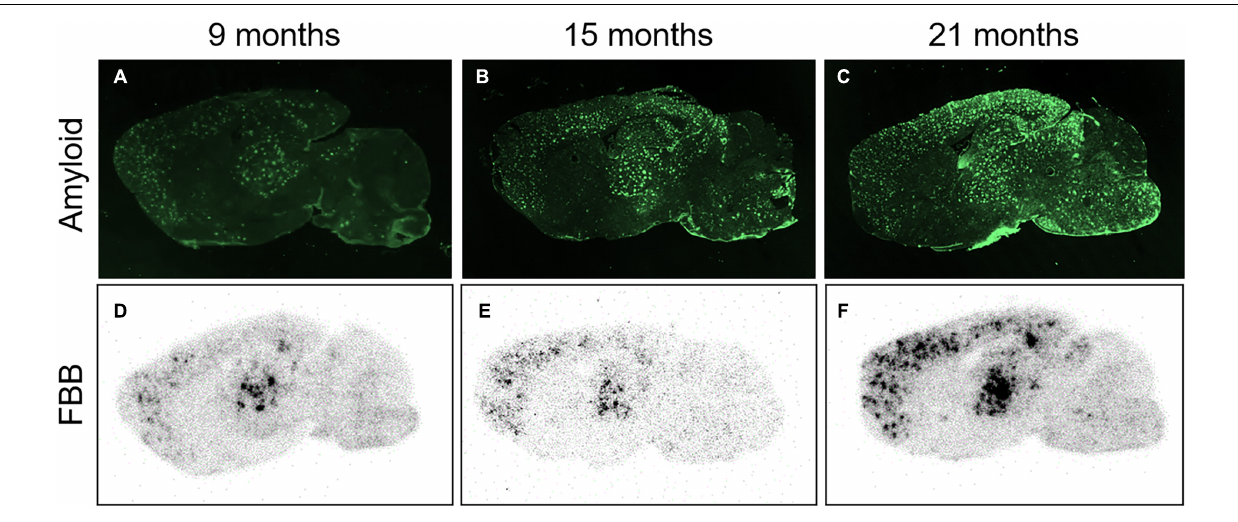
FIGURE 3 | FBB ex vivo autoradiography in comparison to amyloid plaque load. (A–C) Photographs of parasagittal brain sections from transgenic ARTE10 mice stained by immunofluorescence against A β plaques (antibody 6E10) at 9 (A) , 15 (B) , and 21 months of age (C) . Plaque load is increasing with age in ARTE10